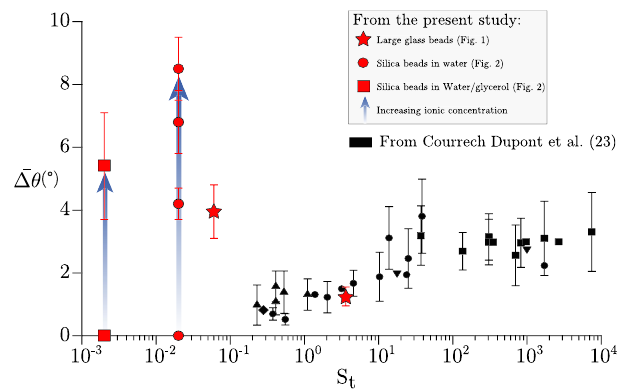
¯ Δ θ FIG. 5. Average amplitude of hysteresis versus Stokes number St. We show the comparison between data obtained by Courrech du Pont et al. (23) (in black) and in the present study. Red star markers correspond to the large glass beads in water and in the mixture of Ucon-oil and water [Fig. 1(c)]. Red circle (resp. square) markers correspond to the silica particles in different salt concentration in water (resp. water/glycerol) [Fig. 2(e)]. For the present study, hysteresis amplitudes were measured at a rotation rate of ω ¼ 10 − 3 ° · s − 1 , except for the silica particles in the water/glycerol mixture where ω ¼ 10 − 4 ° · s − 1 and for the large glass beads where ω ¼ 5 × 10 − 3 ° · s − 1